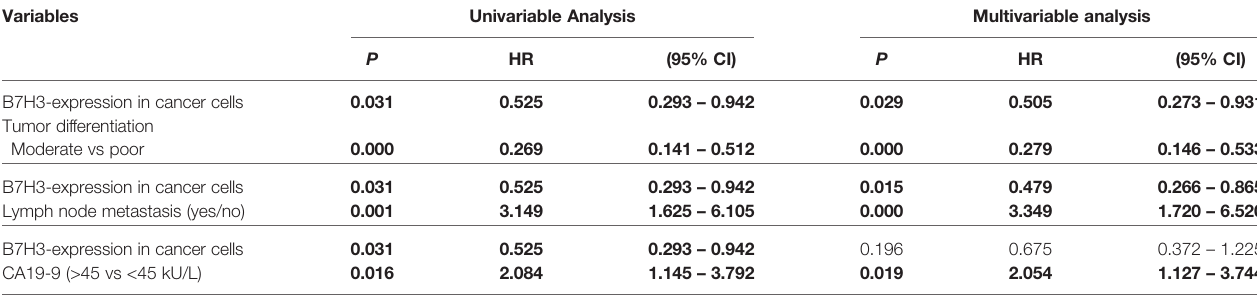
TABLE 3B | Cancer cell B7-H3 expression and tumor differentiation or Lymph node metastasis or